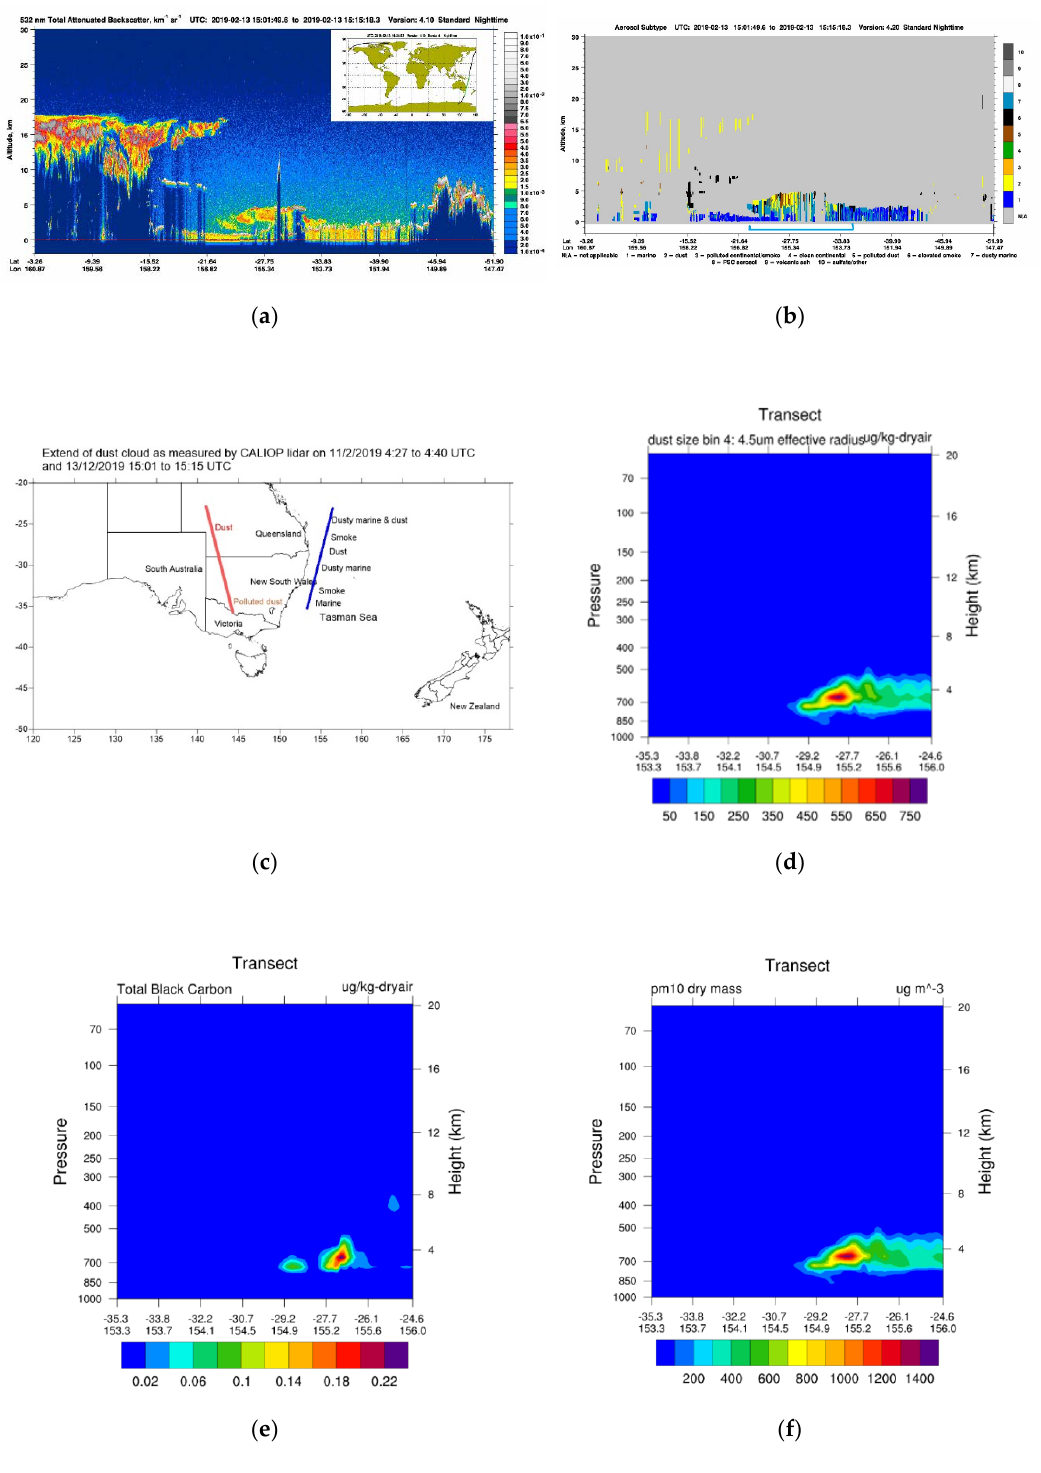
Figure 13. ( a ) LiDAR 532 nm total attenuated backscatter vertical structure on 13 February 2019 from 15:01 to 15:15 UTC with CALIPSO satellite path (inset) on 13 February 2019 above the coast of eastern Australia. ( b ) Aerosol subtype vertical profile as derived from CALIOP measurements. ( c ) Extent of dust clouds as measured by the CALIPSO satellite on 11 February 2019 (red line) and on 13 February 2019 (blue line). The labels correspond to aerosol types at the location indicated. ( d – f ) Transects of WRF-Chem predicted dust of size bin 4, total black carbon and PM 10 on 13 February 2019 15:00 UTC along the same CALIPSO satellite